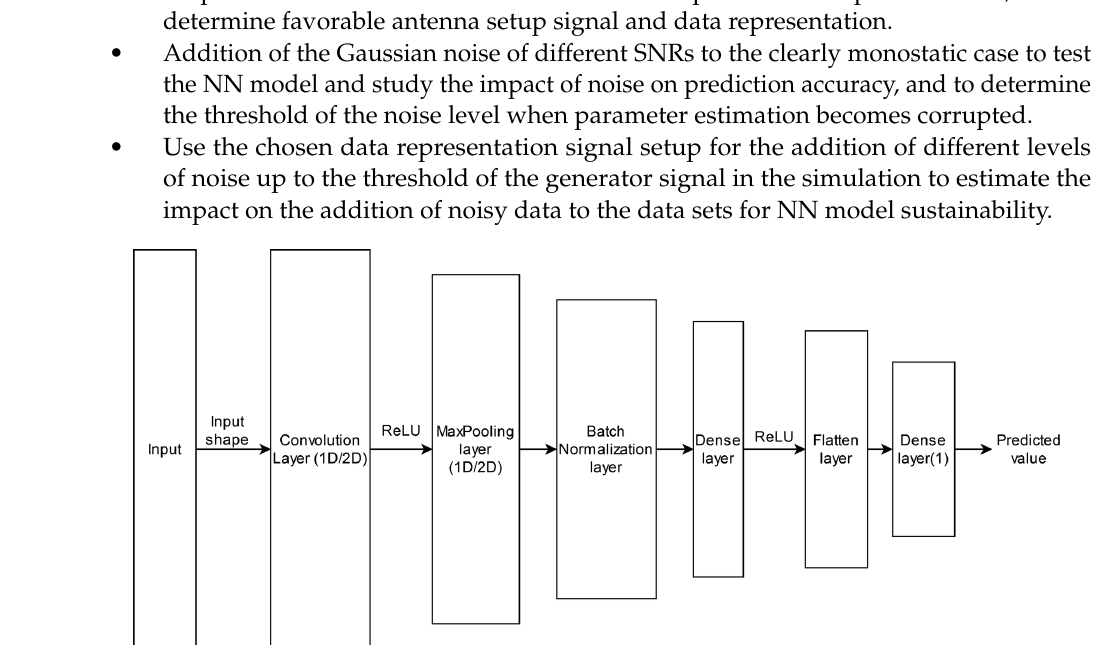
Figure 1. Initial architecture of the model trained using synthetic